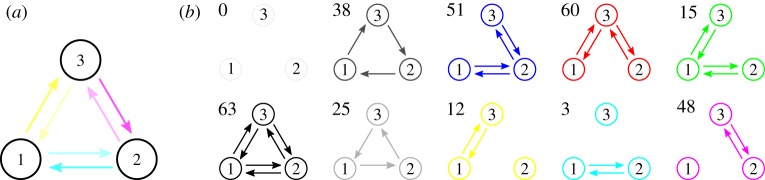
The colour scheme to identify the graphs in H3. (a) The shades of cyan, magenta and yellow identified with each directed edge of K3. If multiple edges are present, the colours are added. Examples of graphs H∈H3 in their associated colours, as well as the corresponding graph numbers ν(H), as defined in (5.1), are shown in (b). The subgraphs where all edges to/from a given node are present (and no others) are associated with the colours red, green and blue. The symmetry that permutes the three nodes acts on the colour scheme by permuting the colour channels. Hence, graphs which are invariant under this symmetry operation have a colour that is invariant under permutation of the colour channels; this includes white for ∅3, black for K3, and shades of grey for the directed cycles C1,2,3, C3,2,1. (Online version in colour.)